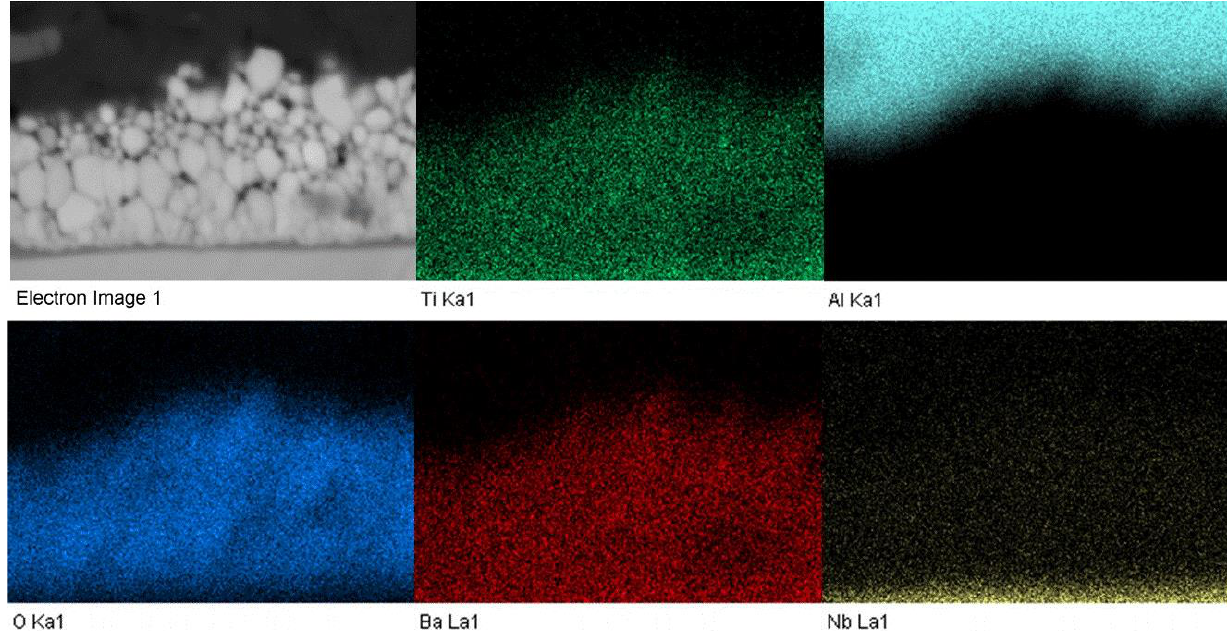
Figure 2. The energy-dispersive X-ray spectroscopy (EDS) analysis is showing the chemical composition throughout the BaTiO 3 film. The colors and their intensity indicate the presence (and amount) of each chemical species, which are designated under each picture (Ti, Al, O, Ba, Nb). The EDS analysis is a proof of the BaTiO 3 existence in the whole film; the K and L are indications of a shell to which the electron transitions during the bombardment. The analysis was performed in five regions of a BaTiO 3 -coated sample, and representative images were selected.